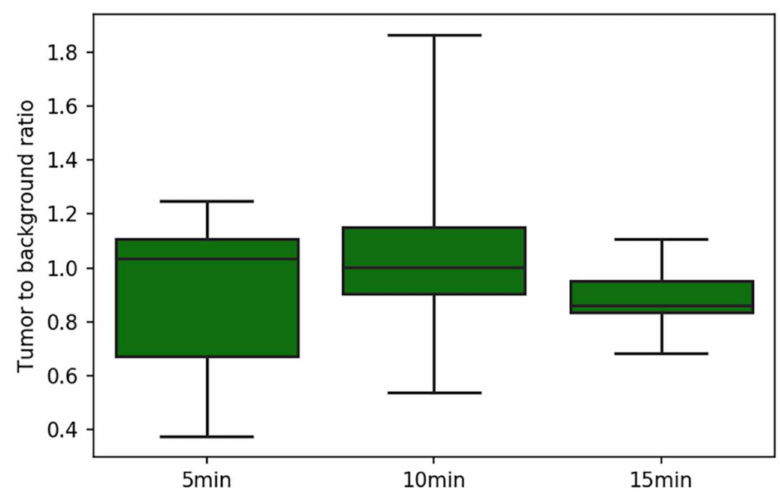
Figure 2. TBRs measured at 3 timepoints. Boxplots represent the median, quartiles, and range of the